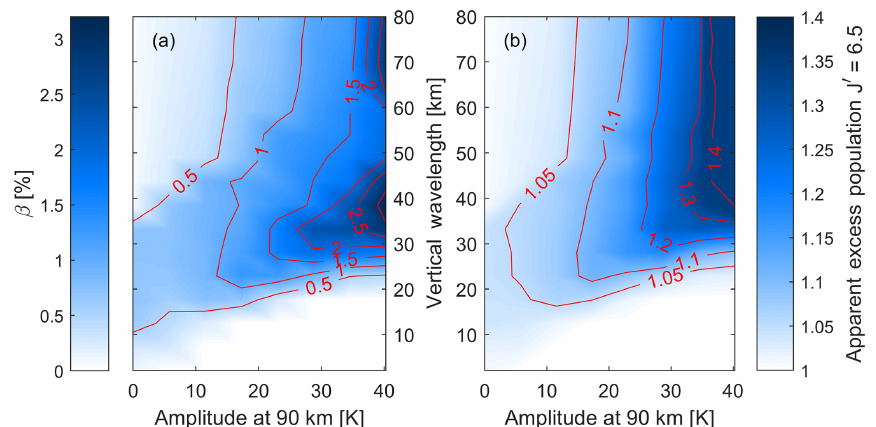
Figure 7. As Fig. 6 but this time for the (3,1) transition. Both the β value from the non-linear fit in (a) and the apparent excess population of the J (cid:48) = 6 . 5 upper level in (b) show a stronger effect than seen for the (7,4) transition in Fig. 6.